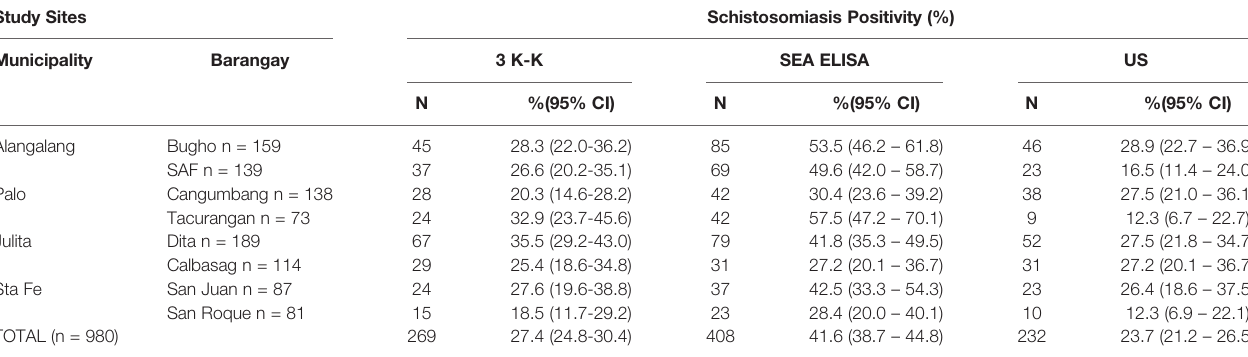
TABLE 1 | Positivity of schistosomiasis at baseline based on conventional diagnostic